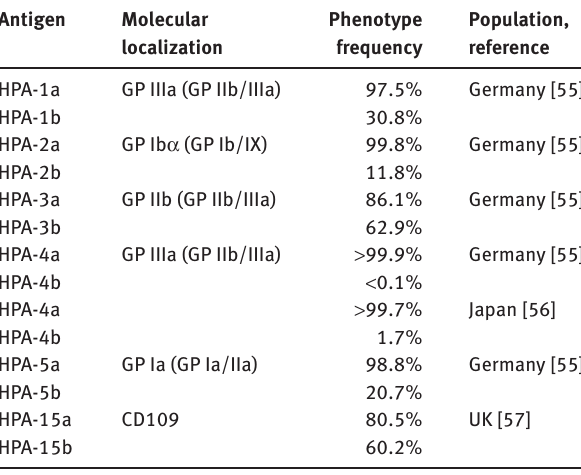
Table 2: Important human platelet alloantigens (HPA).